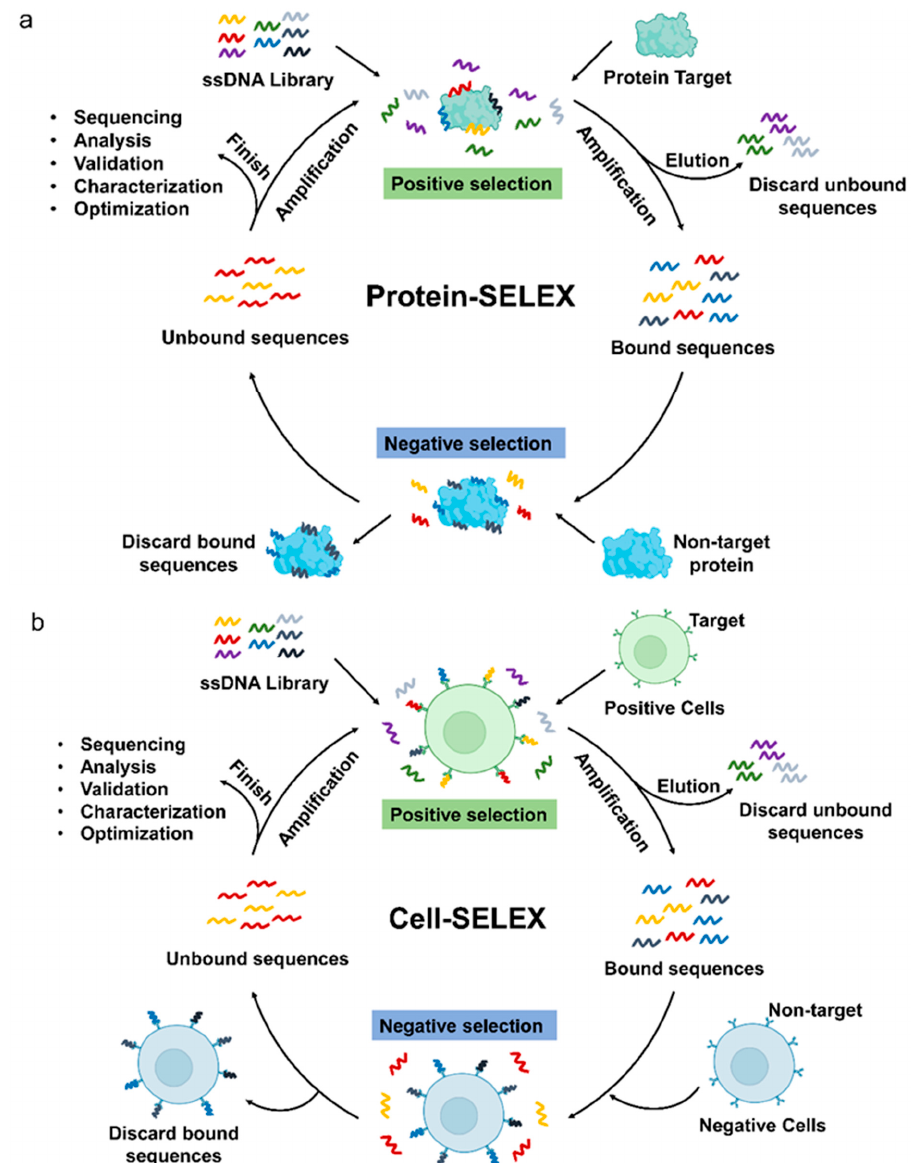
Figure 1. DNA aptamer selection using SELEX. ( a ) Protein-SELEX aptamer selection procedure. Positive selection: Random ssDNA library is incubated with the target protein, then the bound se- quences are separated from the unbound sequences, and the bound aptamers are recovered and